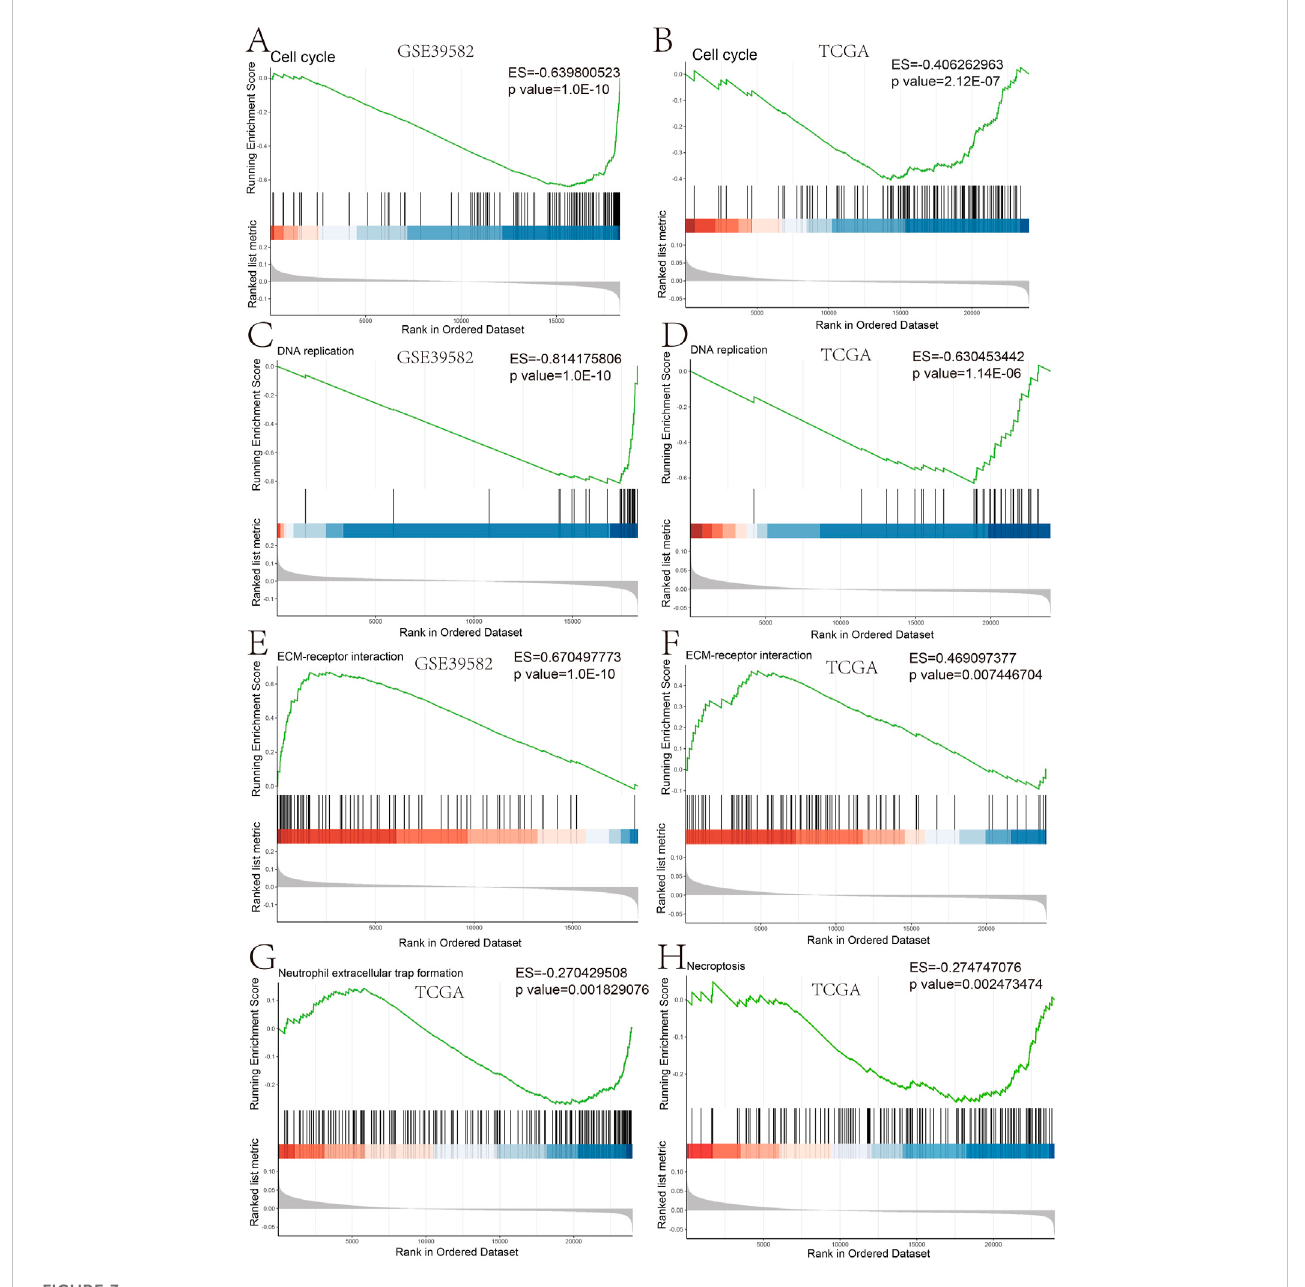
FIGURE 3 GSEA plot of the biological process based on the risk score GSEA analysis in GSE39582 (A,C,E) and GSEA analysis in TCGA (B,D,F – H)